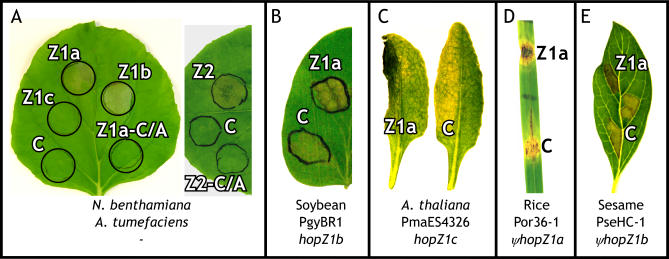
In Vivo Defense Induction AssaysThe plant host, infiltrated strain, and hopZ allele carried by the infiltrated strain are indicated below each leaf image.(A–E) Z1a, Z1b, Z1c, and Z2 represent the infiltration zones of HopZ1a, HopZ1b, HopZ1c, and HopZ2, respectively. Z1a-C/A and Z2-C/A identify the infiltration zone of the HopZ1a and HopZ2 alleles carrying the cysteine-to-alanine replacement in the catalytic core, respectively. C represents the vector control. In all panels HopZ1a induces an HR, while the other infiltrations either result in disease symptoms or no response.(A) Transient expression assay using N. benthamiana leaves infiltrated with A. tumefaciens C58C1(pCH32), carrying HopZ1 or HopZ2 T3SEs in pMDD1 vector.(B) Soybean (Glycine max cv. OAC Bayfield) leaves infiltrated with PgyBR1, carrying pUCP20 or pUCP20HopZ1a PsyA2. PgyBR1 carries hopZ1b natively.(C) A. thaliana (column 1) leaves infiltrated with PmaES4326, carrying pUCP20 or pUCP20HopZ1a PsyA2. PmaES4326 carries hopZ1c natively.(D) Rice (O. sativa cv. Jefferson) leaves infiltrated with Por36–1 carrying pUCP20 or pUCP20HopZ1a PsyA2. Por36–1 carries ψhopZ1a natively.(E) Sesame (S. indicum) leaves infiltrated with PseHC-1 carrying pUCP20 or pUCP20HopZ1a PsyA2. PseHC-1 carries ψ hopZ1b natively.